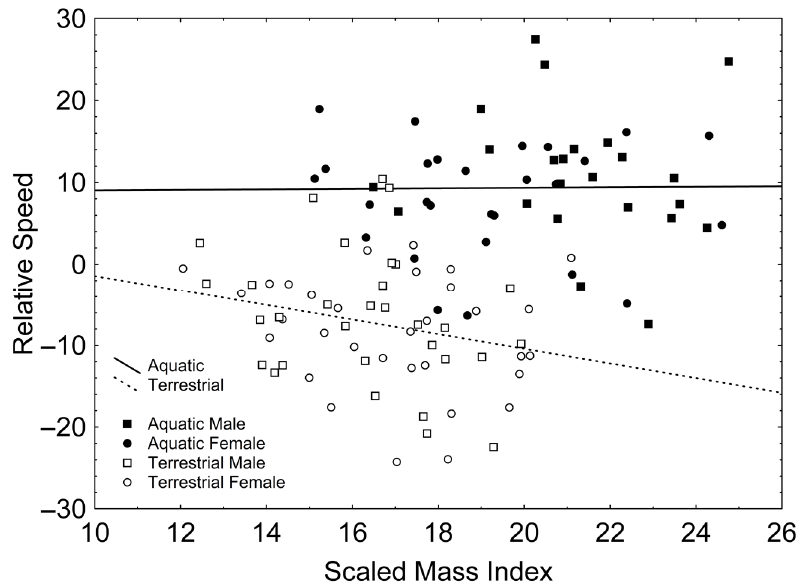
Figure 3. Correlations between the scaled mass index and relative speed in the aquatic (solid line) and the terrestrial phases (dashed line). Squares represent males whereas circles represent females. Solid symbols represent newts in the aquatic phase whereas empty symbols represent newts in the terrestrial phase.